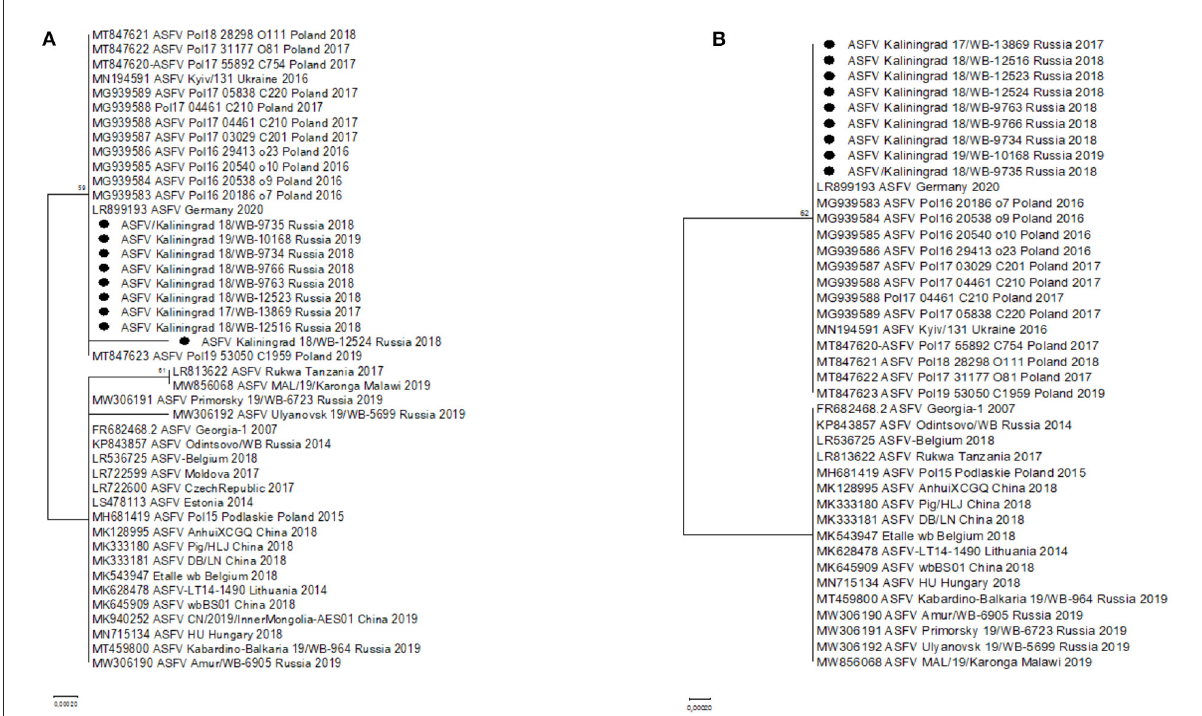
possibly be used to distinguish samples from Kaliningrad from those from the rest of Europe and